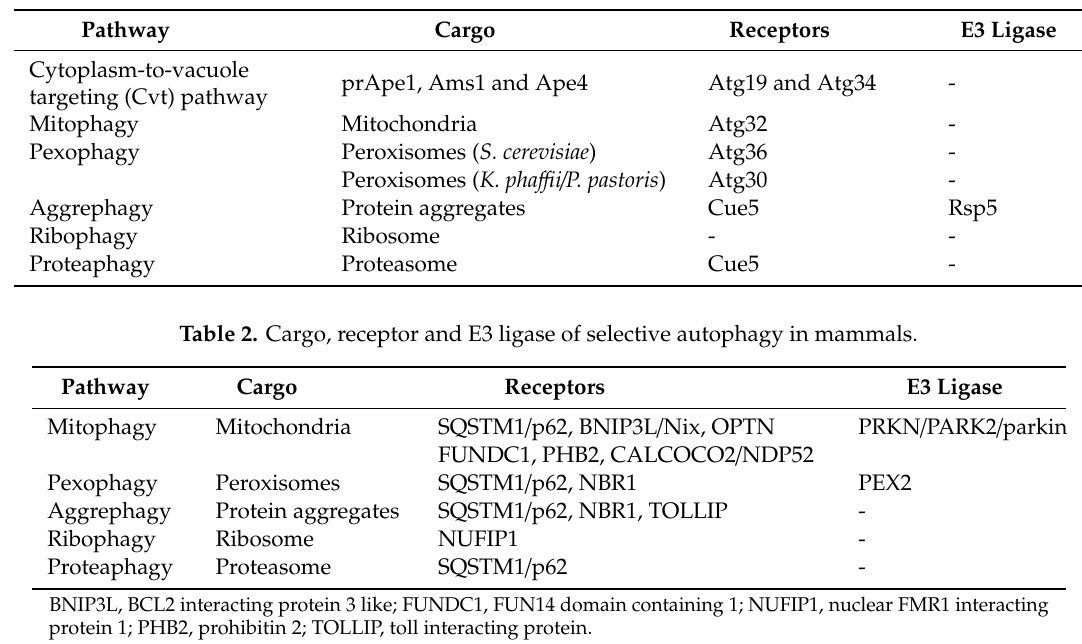
Table 1. Cargo, receptor and E3 ligase of selective autophagy in yeast.